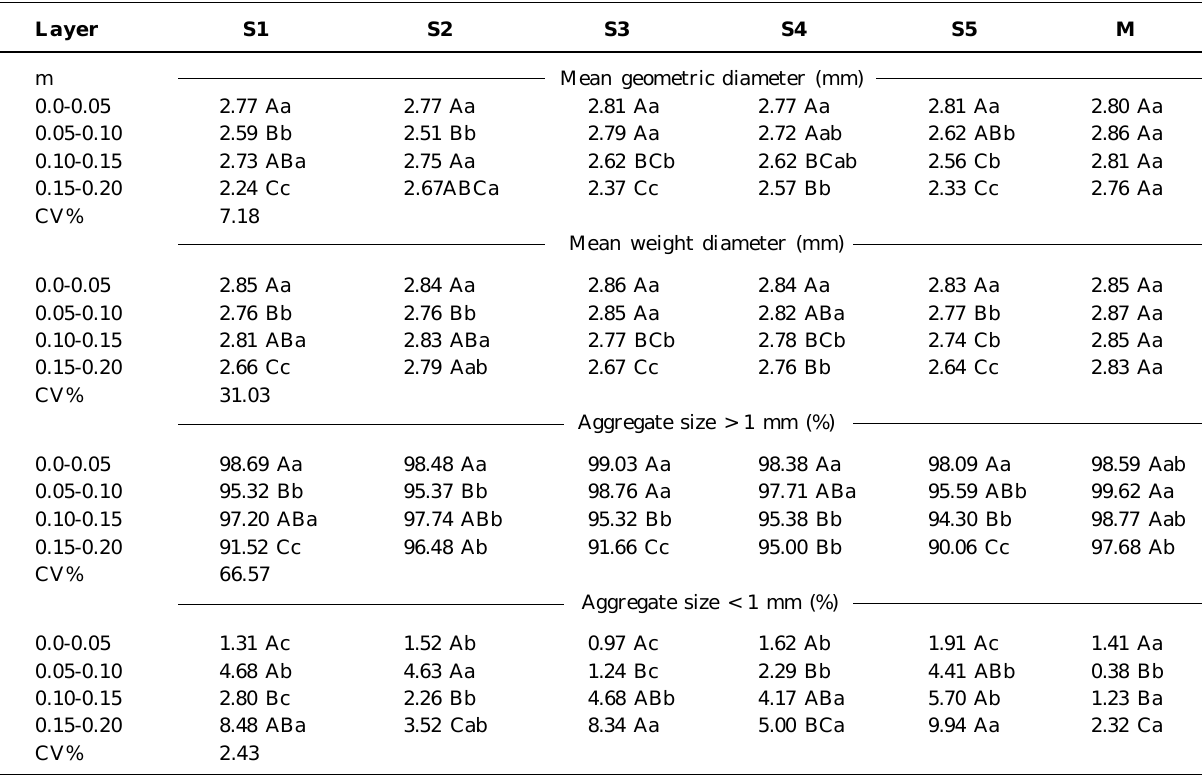
Means followed by the same capital letter in the row and lowercase letter in the column did not differ statistically from each other by the Tukey test at 5